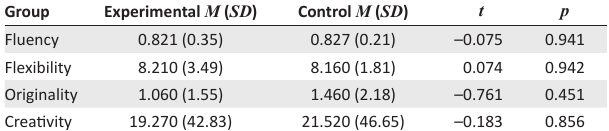
TABLE 3: Means, standard deviations and t -test for creativity scores before the Cognitive Research Trust program ( N = 27 for the experimental group and N = 26 for the control